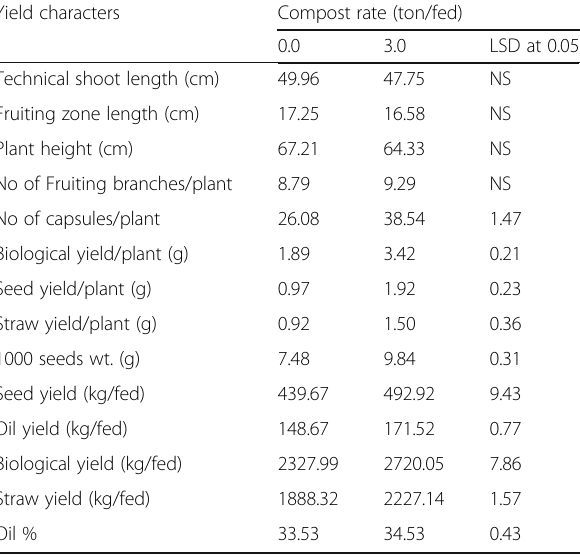
Table 5 Effect of compost with the rate of (3.0 ton/fed) on yield and yield components of flax plant under sandy soil (data